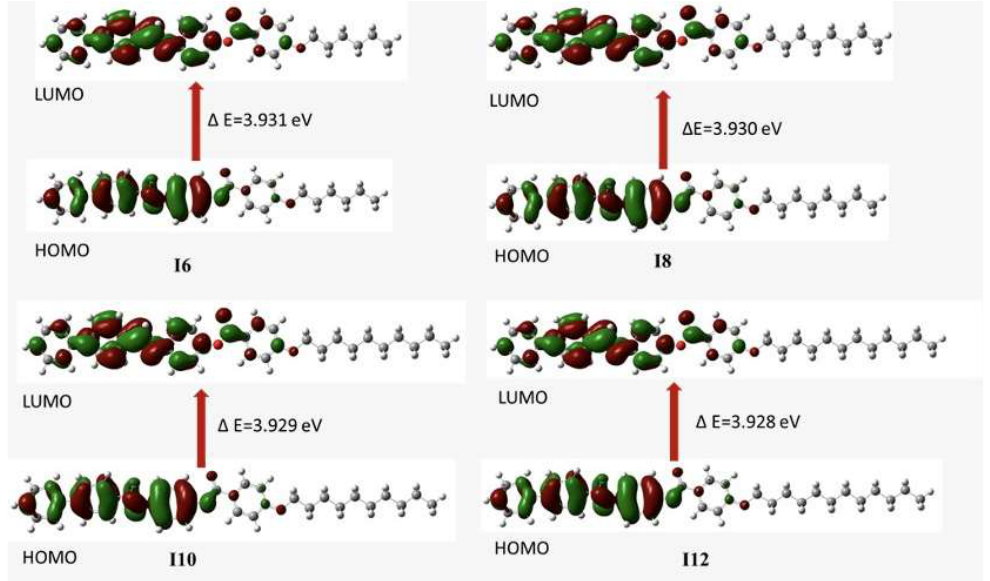
Figure 6. The FMOs for the prepared I n series calculated at the B3LYP/6-31+G(d,p) level of theory. The molecular electrostatic potential energy surface (MEP), which illustrates the elec- tronic density distribution, is a valuable parameter that sheds some light on the electrophilic and nucleophilic centers in a chemical compound. Moreover, it describes the hydrogen- bonding between molecules [49,50]. The MEP of the I n series has been calculated using the geometries of the compounds optimized at B3LYP/6-31+G(d,p). The negative sites (red) of the MEP are characterized by a greater electron density and are related to the nucleophilic reactivity. The positive sites (green or blue) are the area of low electron density and are associated with the electrophilicity. The potential energy range of the potential map was found to be − 5.221e − 2 esu to + 5.221e − 2 esu. In all the I n series, as shown in Figure 7, the O and N centers had high electron density and represented the nucleophilic part, while low electron density was observed around the alkyl